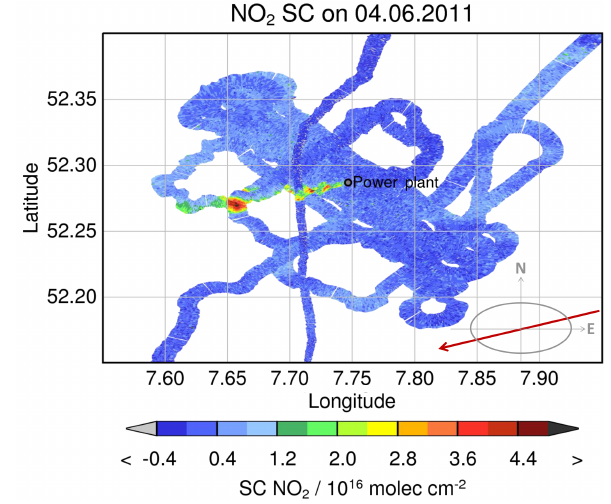
Figure 9. Map of NO 2 slant columns measured during the flight on 4 June 2011 above the area around the Ibbenbüren power plant. The elevated levels of NO 2 are clearly visible in the exhaust plume downwind of the power plant stack. In the bottom right corner of the map, the wind direction is